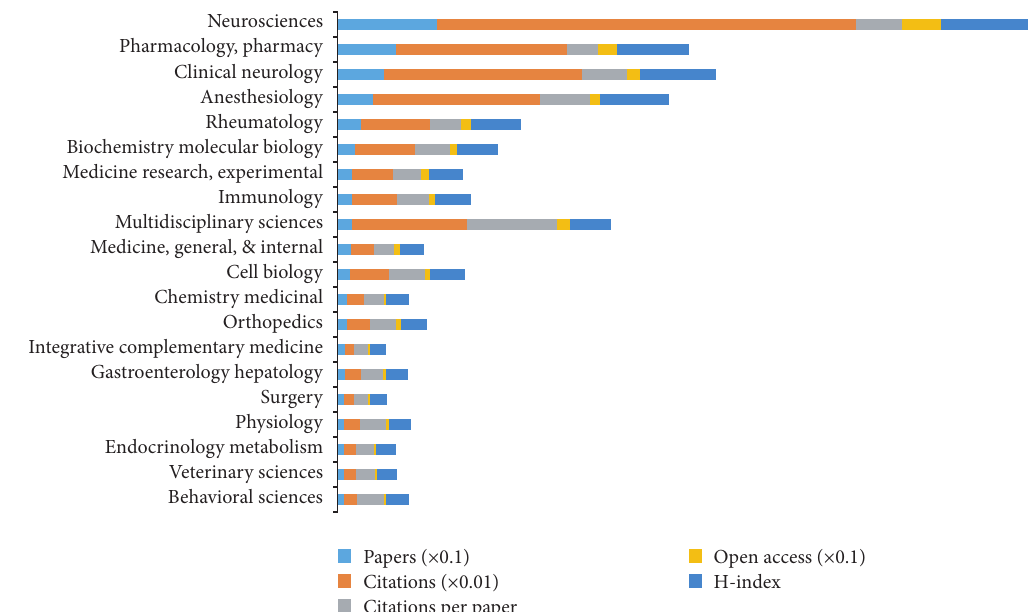
Figure 4: Number of papers, citations, citations per paper, open access papers, and H-index of the top 20 subject categories of WOS.